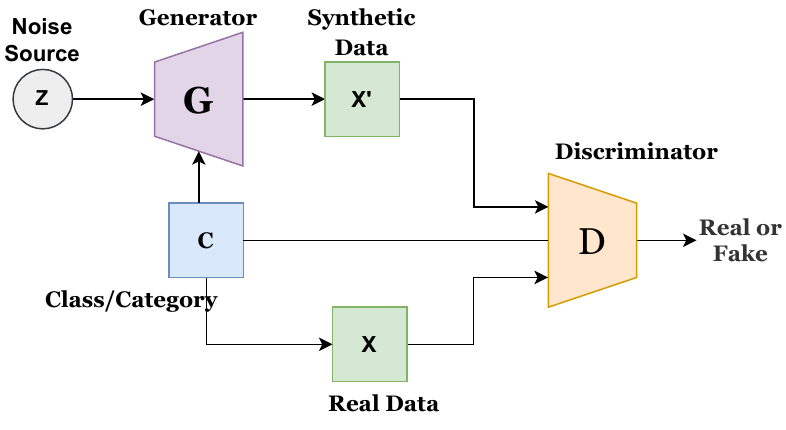
Figure 1. Architectural diagram of existing CGAN.